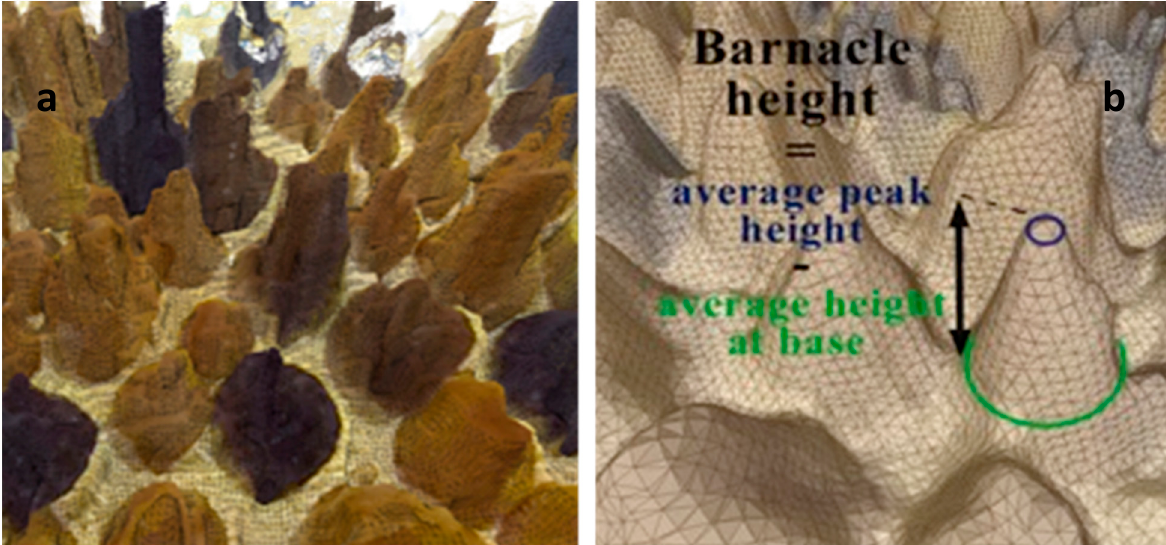
Figure 13. Numerical mapping ( a ) and computation of specimen height ( b ).